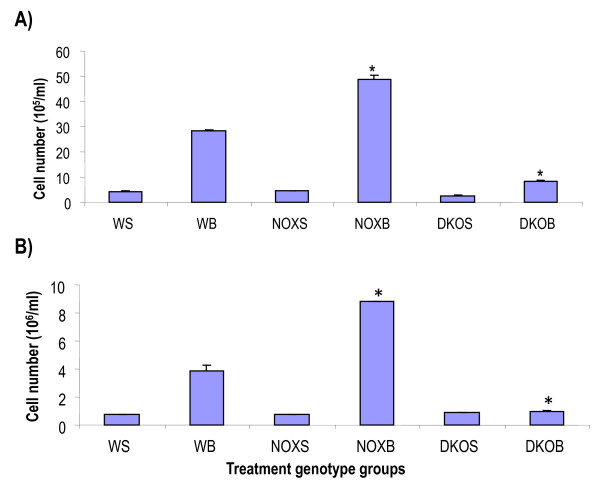
Cellularity in bronchoalveolar lavage fluid and lung before and after bleomycin challenge at day 7 in wildtype vs. gp91phox-/- and MMP12-gp91phox double knockout mice. Airways were lavaged and cells counted by a Z1 particle counter from Beckman Coulter. Lung lobes were excised after thorough exsanguination of the mouse by infra-orbital bleeding after ligation of the superior vena cava. Minced parenchyma was digested with dispase and the resultant cell suspension, filtered of cell debris, was stained with Hoechst dye, and cellularity assessed. *P < 0.05 compared to control, averaged from three independent experiments. FACsans and flow sorts were done in triplicate per sample. Samples were counted in duplicate tubes per sample for each data point (n = 4 to 5 per group). Mortality was less than 2%. Abbreviations: WS, saline-treated wildtype mice; WB, wildtype mice treated with bleomycin; NOXS, saline-treated gp91phox null; NOXB, bleomycin-treated gp91phox null; DKOS, saline treated MMP12- gp91phox double knockout; DKOB, bleomycin-treated MMP12- gp91phox double knockout.